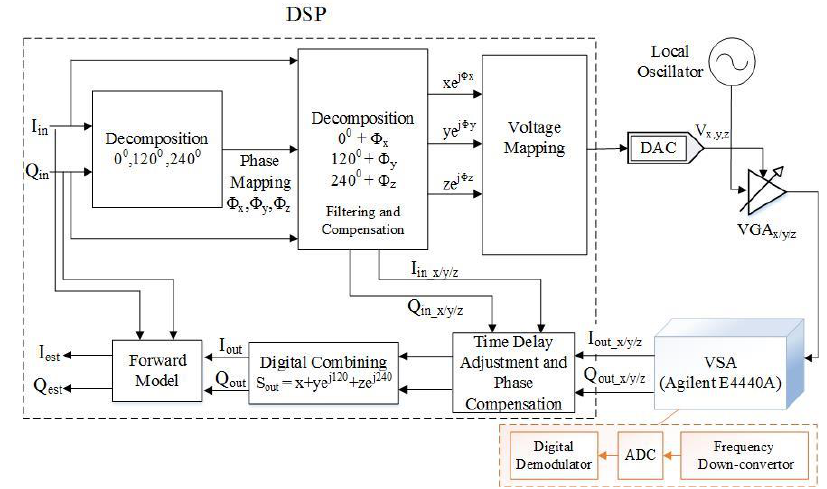
Figure 6. Block schematic of the mixer-less three-way amplitude modulator-based transmitter, branch-by-branch digital combining with signal processing.